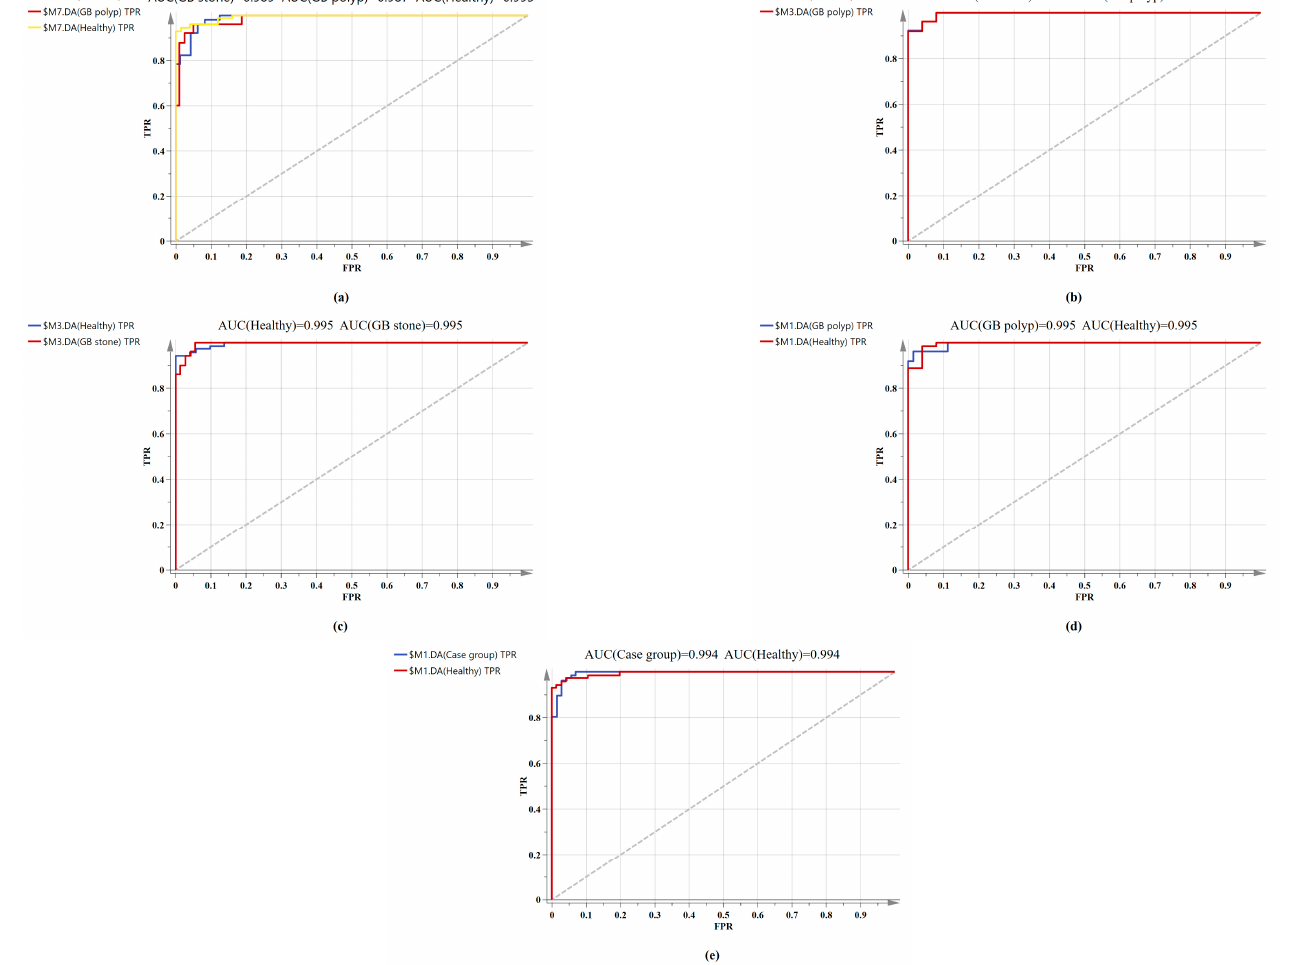
Figure 5. Comparison of ROC curves of serum SERS spectral utilizing the OPLS-DA algorithm. ( a )